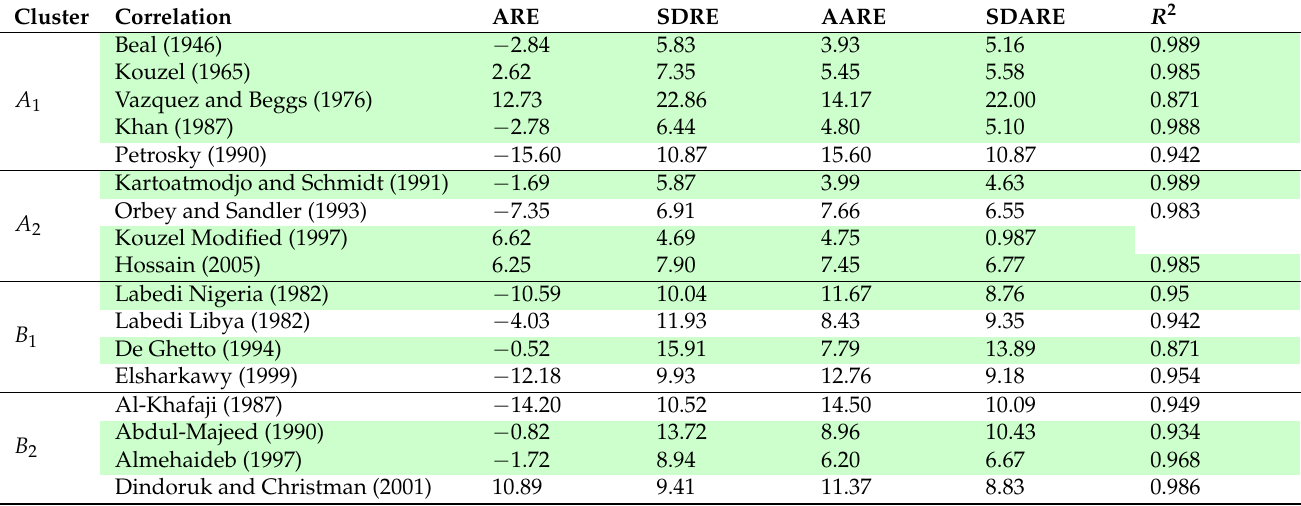
Table A3. Detailed metric values for all correlations and for µ ob range 5–20.